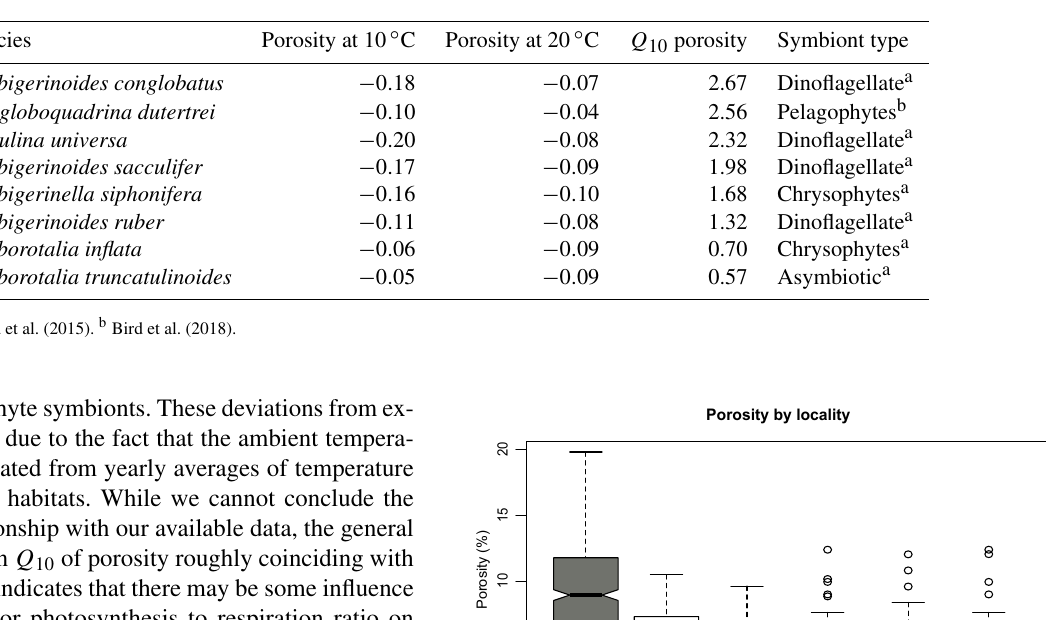
Table 3. Magnitude of porosity increase with a 10 ◦ C temperature increase, as inferred from regressions of average size-normalized porosity and sea surface temperature for core-top species that occurred at more than two localities. The size-normalized porosity average at 10 ◦ C and 20 ◦ C is listed, along with the factor by which porosity increases over this interval ( Q 10 ). See Fig. S6 for plots.